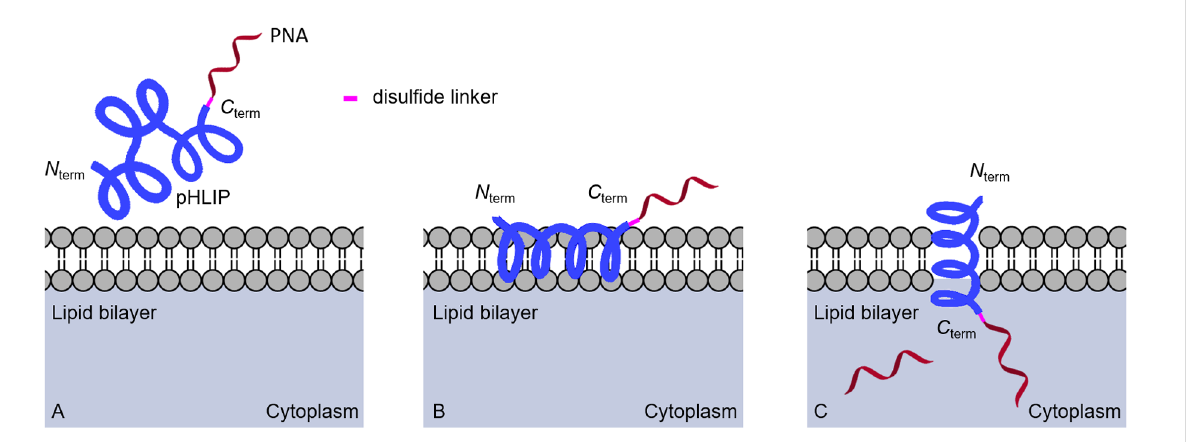
Figure 13: Proposed delivery mode by pHLIP-PNA conjugates (A) the transmembrane section of pHLIP interacting with lipid bilayer, (B) low surface pH leads to partial protonation of negative residues triggering interfacial helix formation and deeper partitioning into lipid bilayer, and (C) the trans- membrane helix formation and release of PNA into cytosol by disulfide